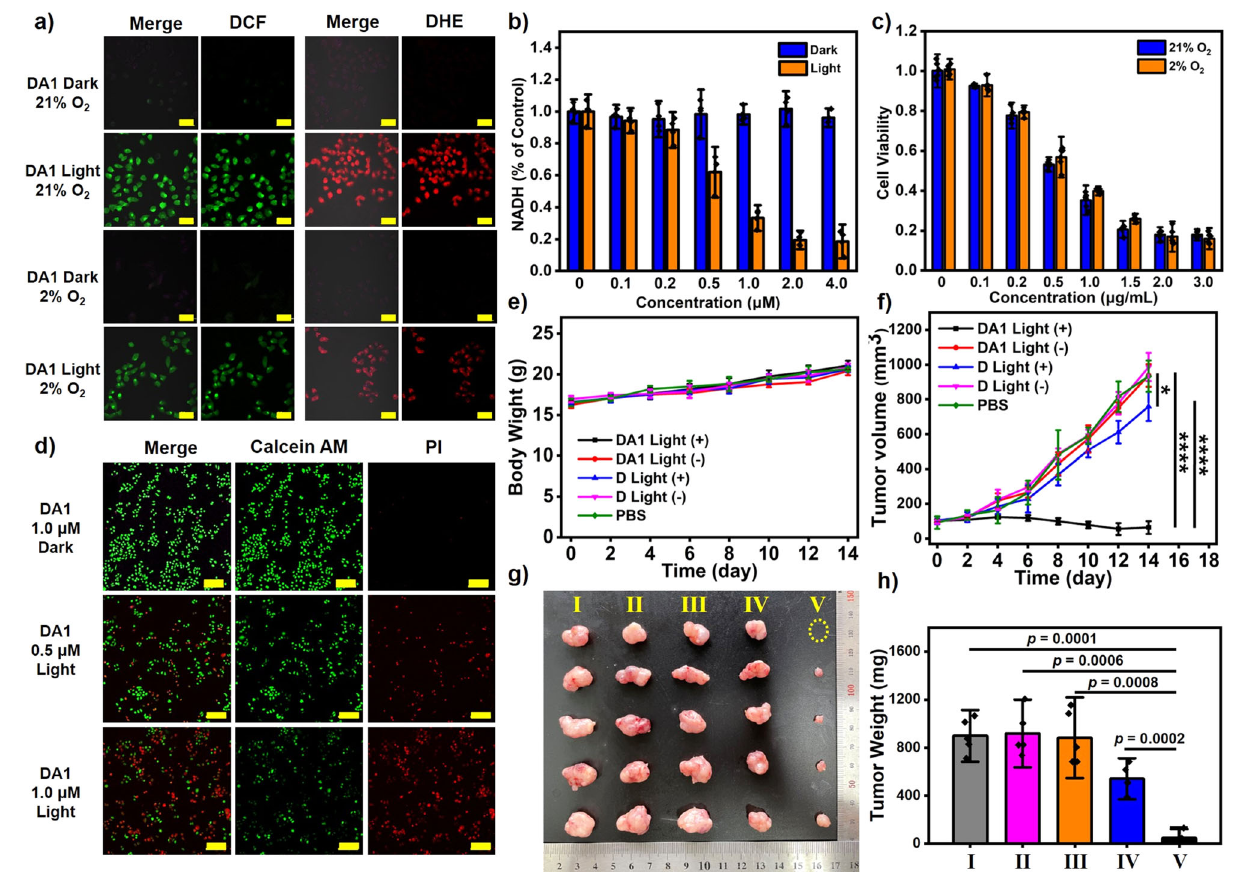
Fig. 6 | PDT ef fi cacy of supramolecular photosensitizers in vitro and in vivo. a Detection of ROS and O 2 − • in HeLa cells with DCFH-DA and DHE under nor- moxic (21% O 2 ) or hypoxic (2% O 2 ) conditions. The scale bar represents 50 μ m. b Quantitative analysis of intracellular NADH level in Hela cells subjected to a range of DA1 concentrations. Data were presented as mean ± s.d. derived from n = 5 independent biological samples. c Cell viability of HeLa cells subjected to a range of DA1 concentrations in the presence of light irradiation under nor- moxic or hypoxic conditions. Data were presented as mean± s.d. derived from n = 6independentbiologicalsamples. d CLSMimagesofcalcein-AM/PI-stained